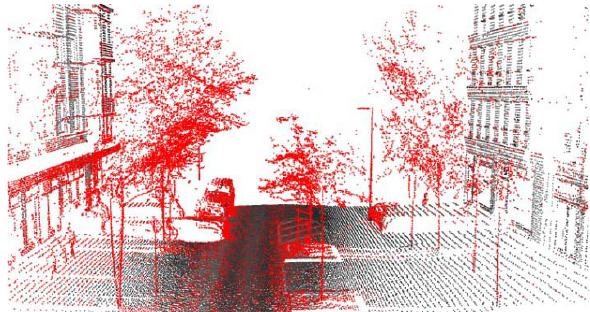
Figure 8: Classified points of the automotive LiDAR data. Dynamic points are colored red, static points are colored by their intensity